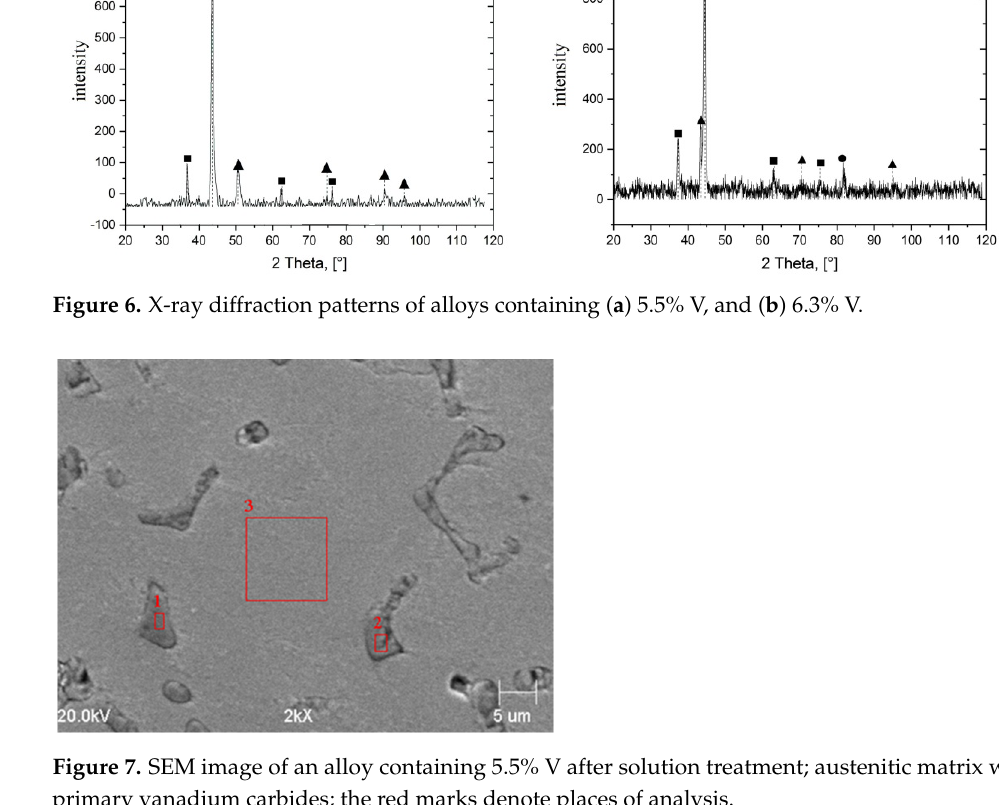
Figure 6. X-ray diffraction patterns of alloys containing ( a ) 5.5% V, and ( b ) 6.3% V.